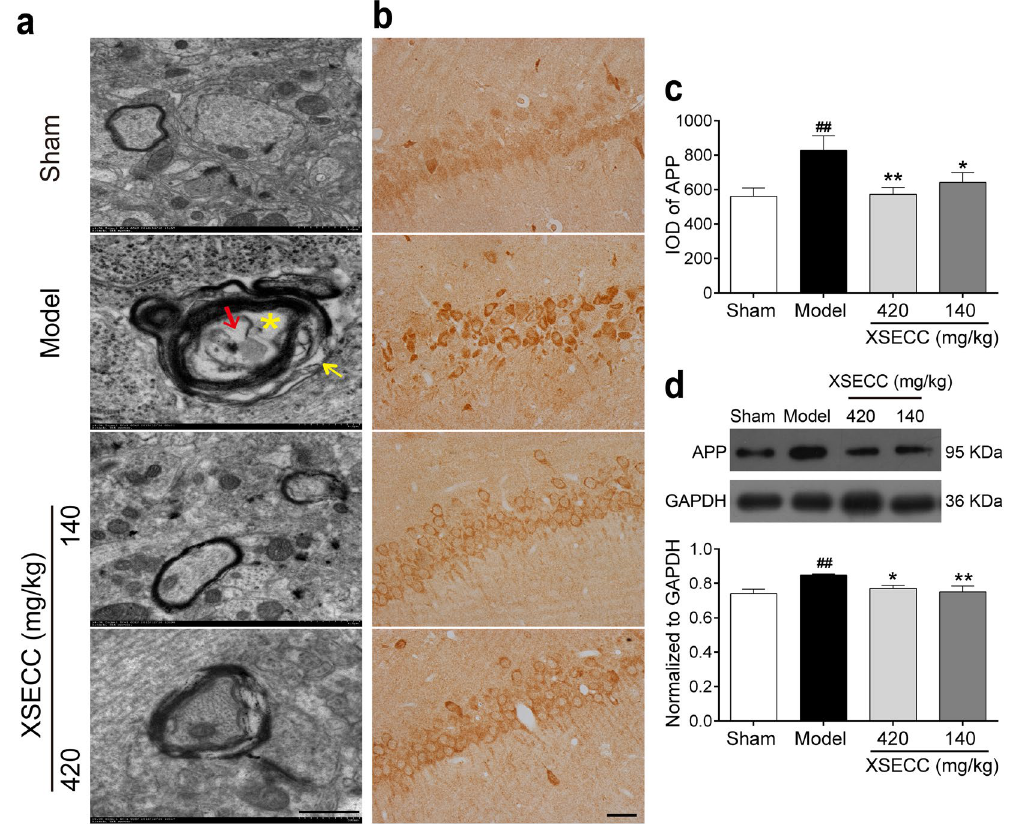
Figure 5. Effects of XSECC on axonal damage in BCCAO rats. ( a ) Typical TEM images of axonal ultrastructure from sham, model and XSECC group rats. (Yellow arrow represented loss of myelin sheath, yellow asterisk represented swollen axon, and red arrow represented degenerated axon, scale bar = 100 nm, n = 2 per group). ( b ) Immunohistochemistry staining of APP in the hippocampus CA1 area (scale bar = 50 μ m, four sections per animal). Immunohistochemical ( c ) and western blot ( d ) analysis of APP protein expression in the hippocampus (n = 6 per group). ## P < 0.01 vs . sham group; * P < 0.05, ** P < 0.01 vs . model group (one-way ANOVA followed by LSD’s post hoc